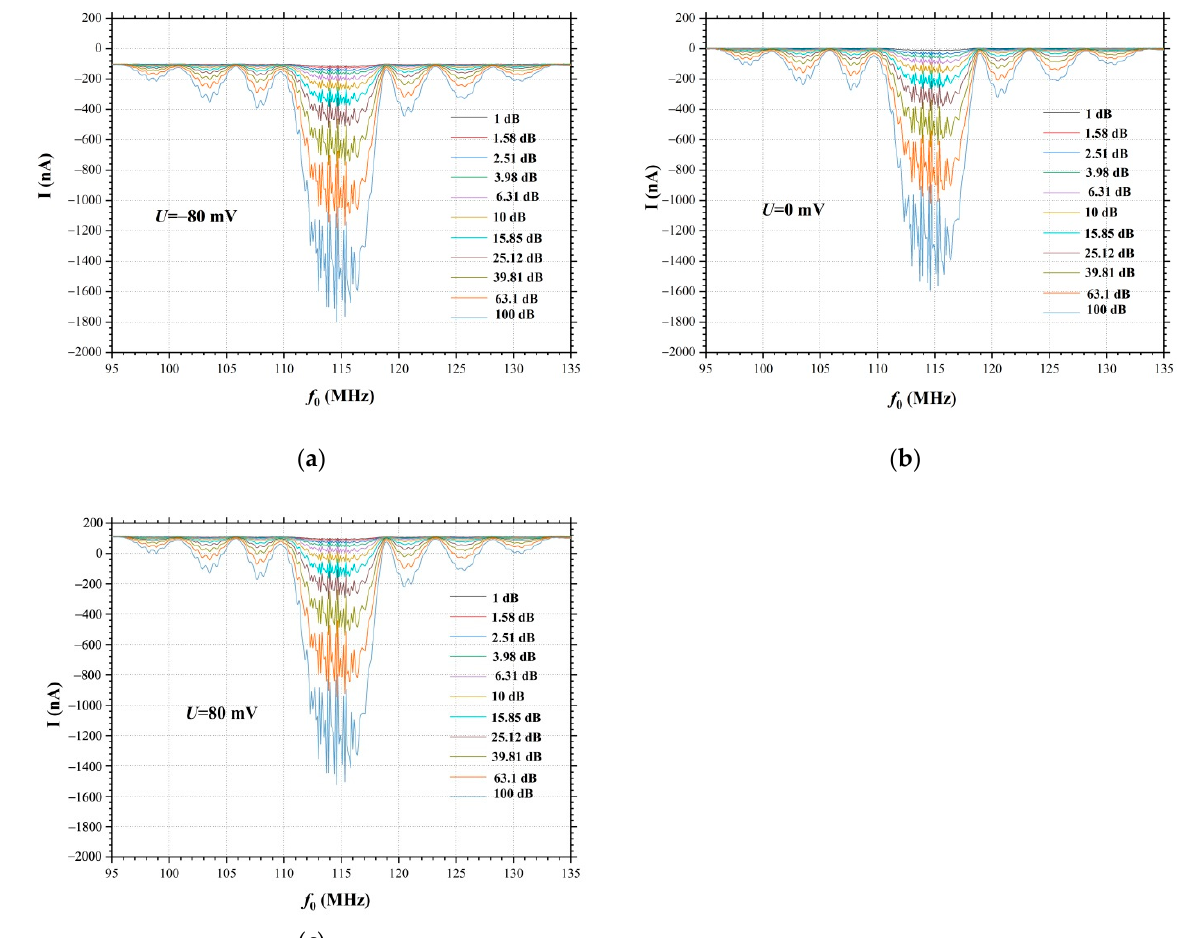
Figure 5. Dependences of the current in the graphene film on the bias potential U and the amplitude of the input signal supplied to the IDT (1÷100 dB): ( a ) 𝑈 = −80 mV, ( b ) 𝑈 = 0 mV, ( c ) 𝑈 = −80 mV.